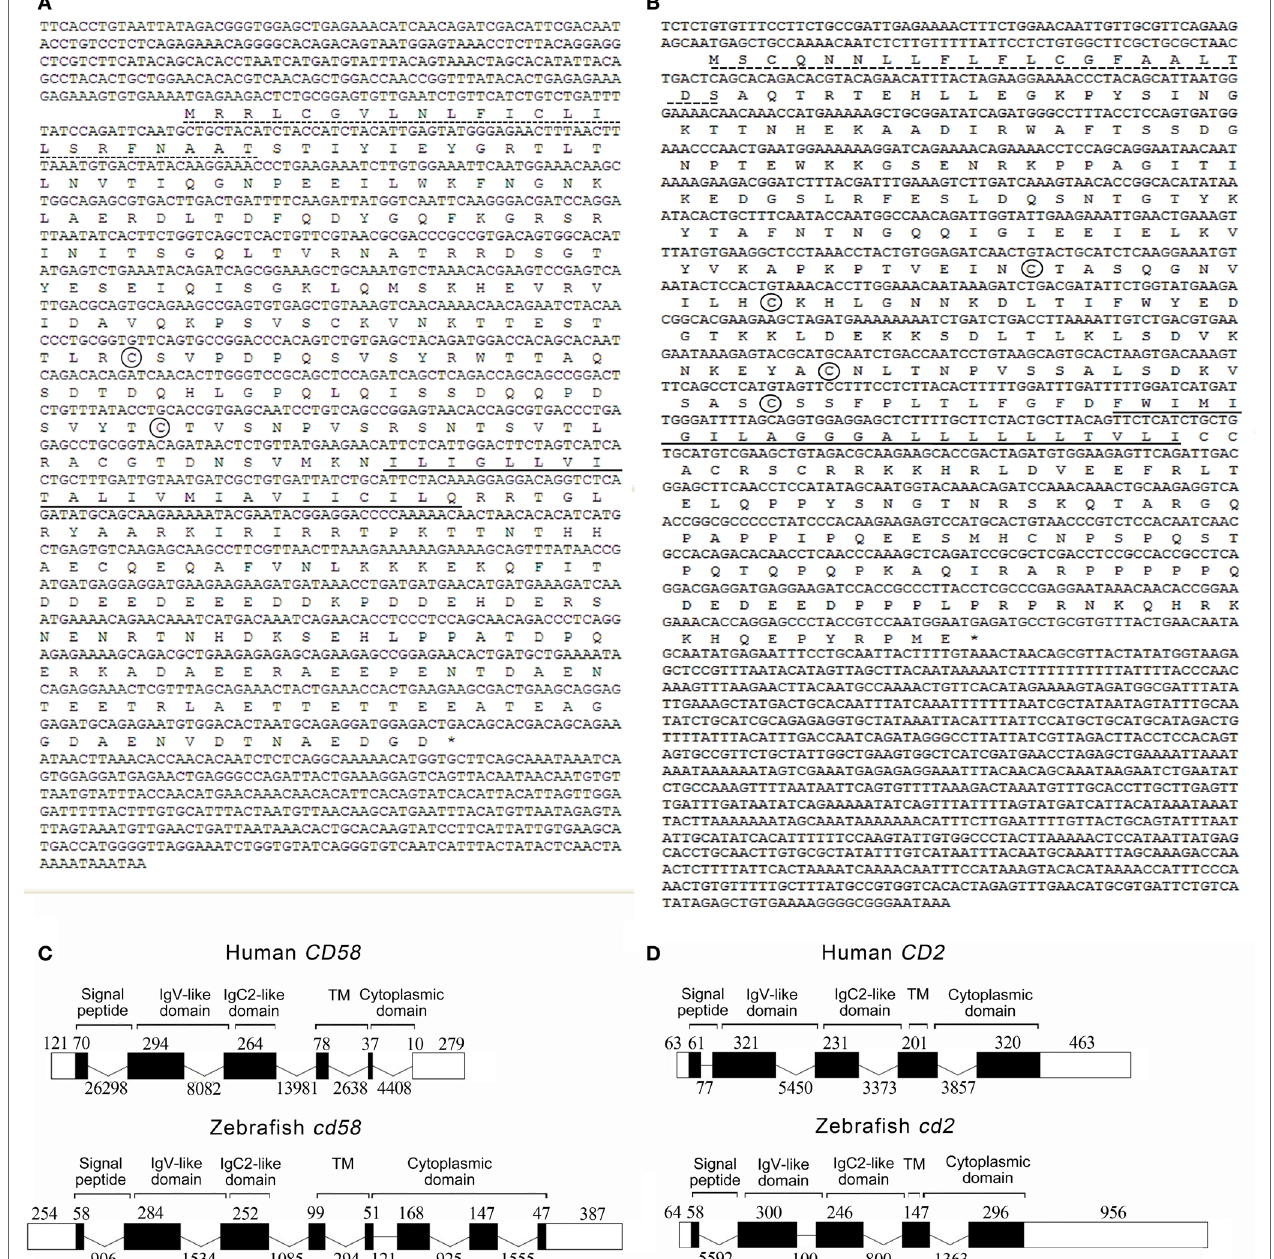
FigUre 1 | (a,B) The cDNA sequences and deduced amino acids of cd58 and cd2. The signal peptide and transmembrane domain are underlined with the dotted and solid lines, respectively. Two conserved cysteines in Cd58 and four in Cd2 amino acid sequences forming IgC2-like domain structures are encircled, respectively. The asterisk represents the stop codon. (c,D) Comparison of the intron/exon organizations of the CD58 and CD2 genes in humans and zebrafish. Exons and introns are shown with the black boxes and lines, and their sizes are indicated by the numbers found above and below the sequences, respectively. Black and white areas indicate the coding regions and untranslated regions, respectively. Schematic diagrams were included above the exon/intron organization cartoons to indicate the exons in terms of protein domains, including signal peptide, IgV domain, IgC2-like domain, transmembrane domain (TM), and cytoplasmic